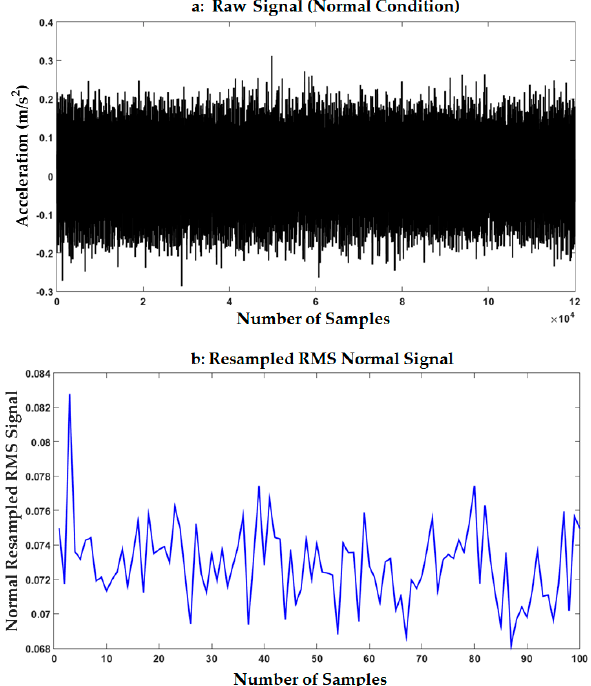
Figure 3. RAW signals and resample signals: ( a ) the normal raw signal of a bearing, and ( b ) the resampled RMS signal extracted from the raw signal.